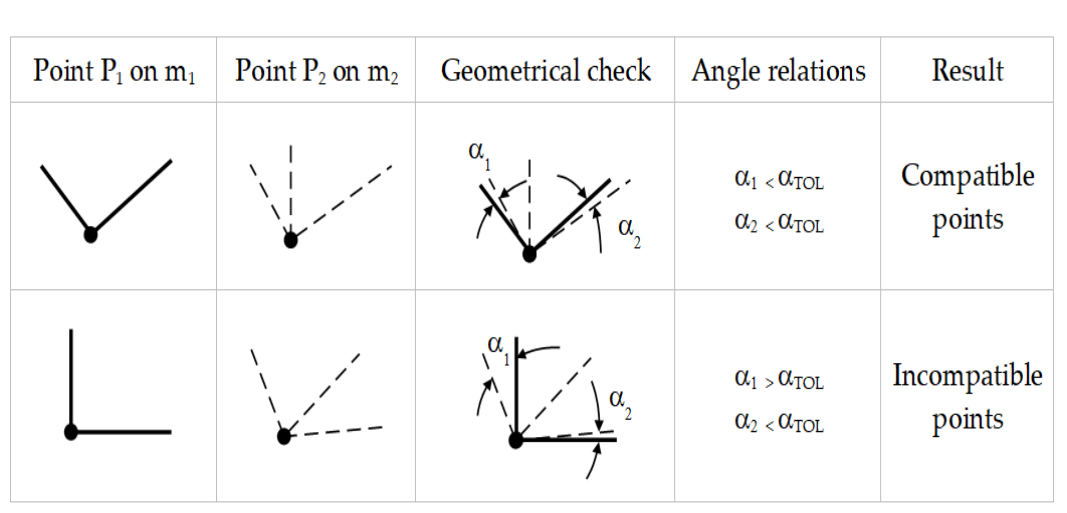
Figure 3. Examples of compatible/incompatible homologous points.